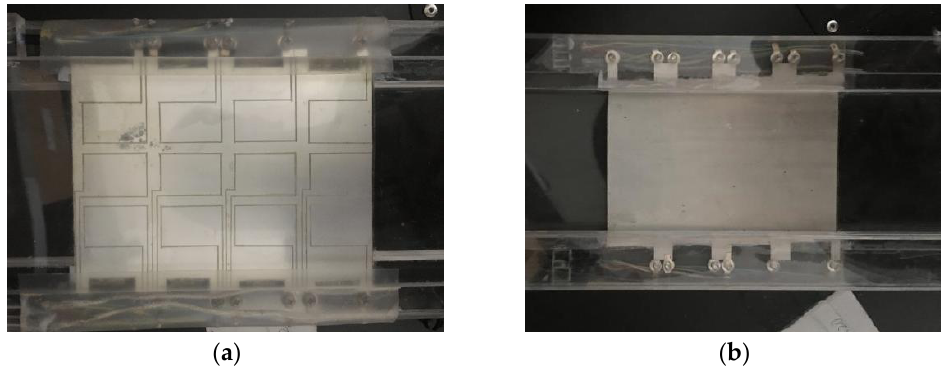
Figure 2. Photographs of PVDF film. ( a ) Upper surface of PVDF film, ( b ) L ower surface of PVDF film.